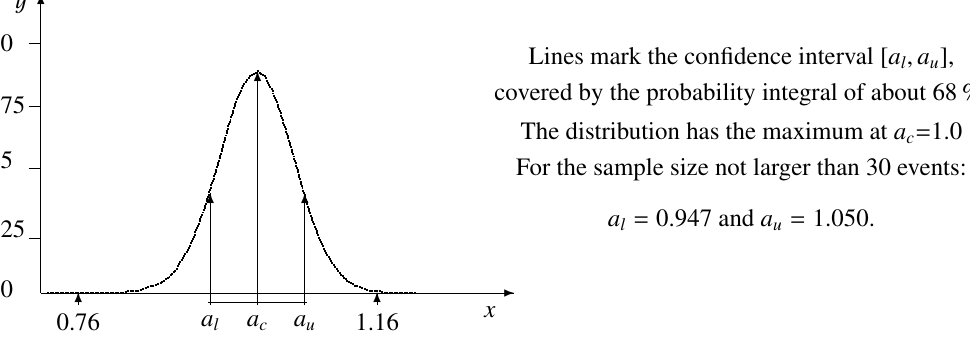
Figure 2. The distribution of M m (normal case). The values along the coordinate axes have the same meaning as in Fig.